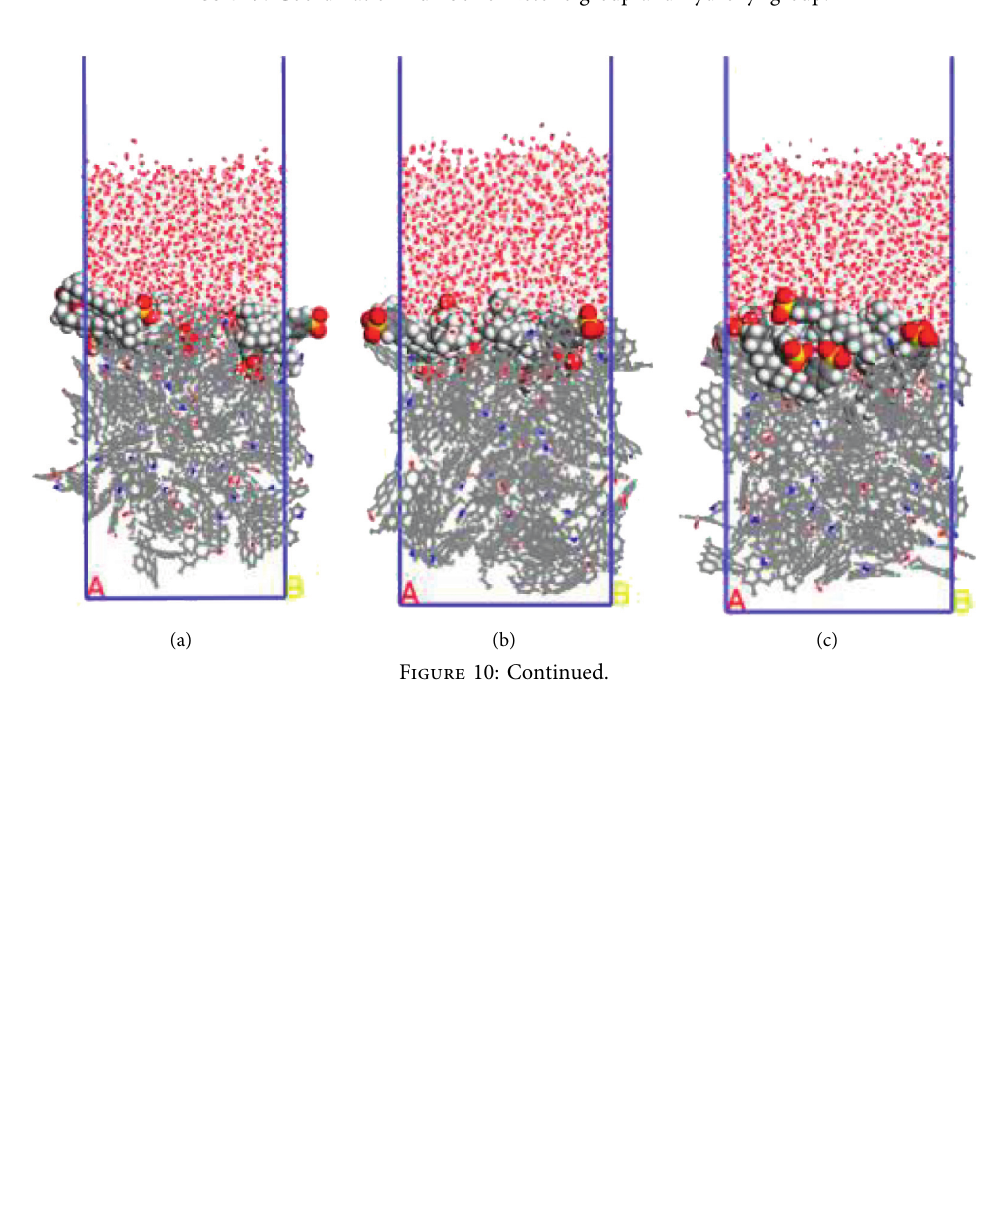
Figure 9: Coordination number of ketone group and hydroxyl